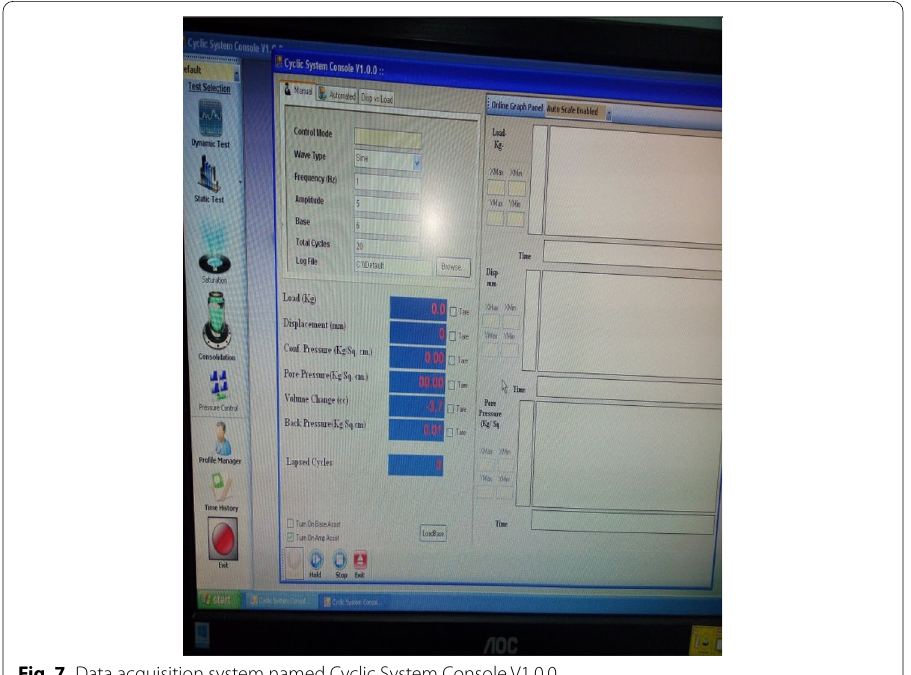
Fig. 7 Data acquisition system named Cyclic System Console